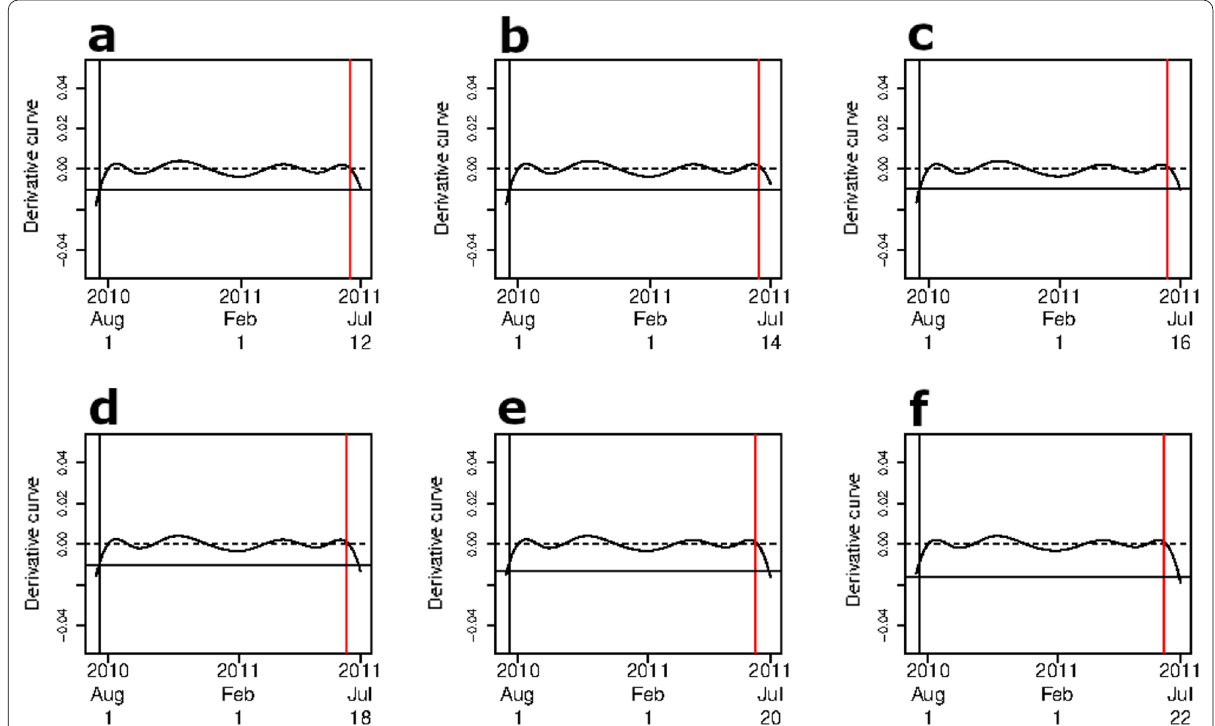
Fig. 12 Derivative curves of the displacement curves in the p‑splines basis by considering data series up to 14, 16, 18, 20, 22 and 24 days after Jun 28, 2011. The black vertical line indicates the beginning of the timeseries data used to calculate the minimun slope level. When calculating the